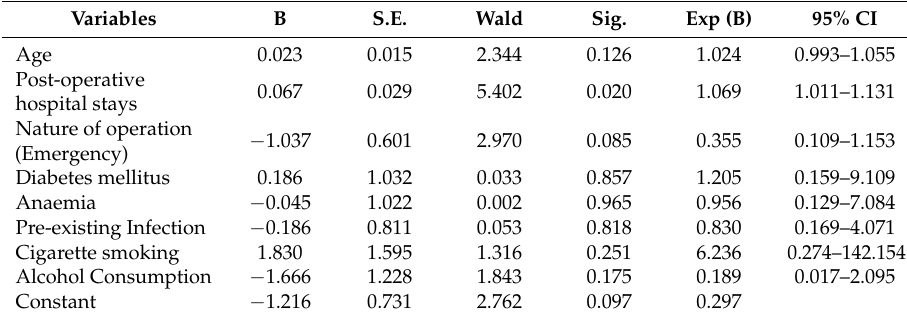
Table 2. Multivariate logistic model on predictors of SSI at surgical ward of the hospital.